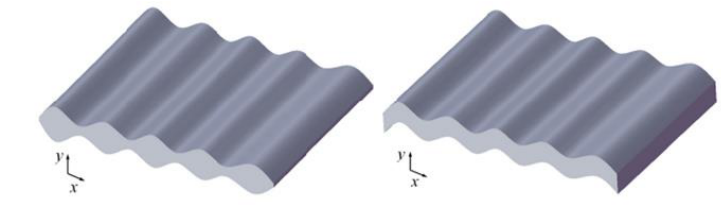
Figure 2. The figure of the liquid sheet “varicose” and “sinuous” modes. Substituting Equation (18) into Equations (2)–(5) and the constitutive relation in Equation (19), the solution of the disturbance flow field can be obtained with a set of integration constants, which can be determined from the boundary conditions in Equations (14)–(17). The requirement of a nontrivial solution to the linear homogeneous equations leads to the dispersion relation.